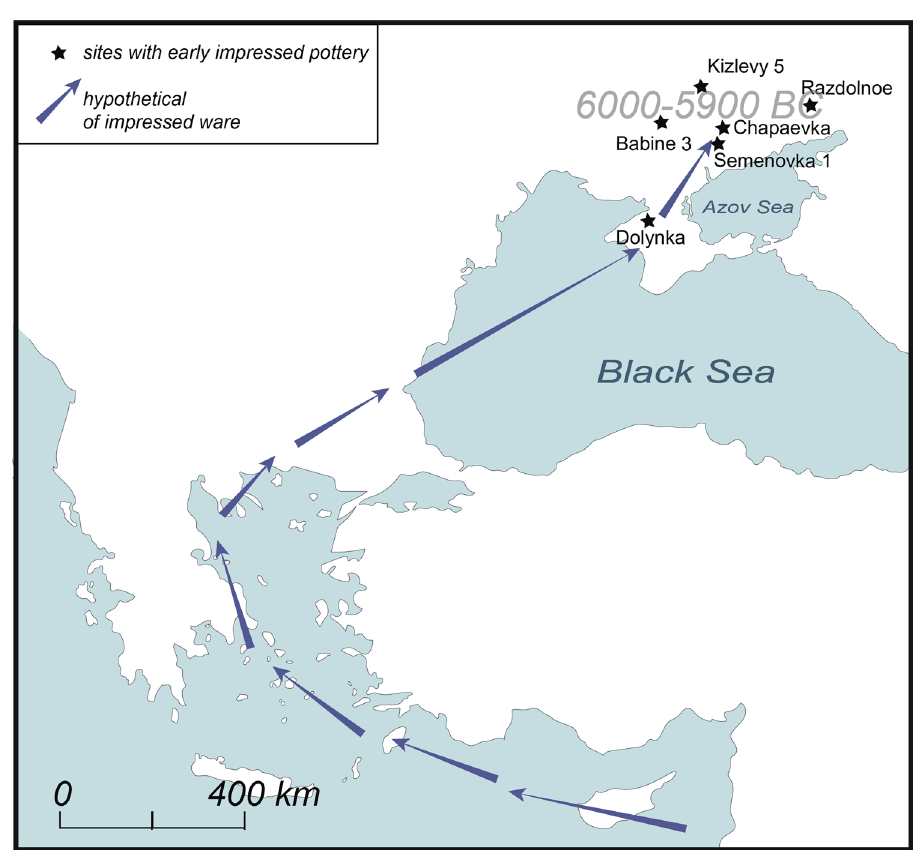
Figure 1: Distribution map of impressed pottery in